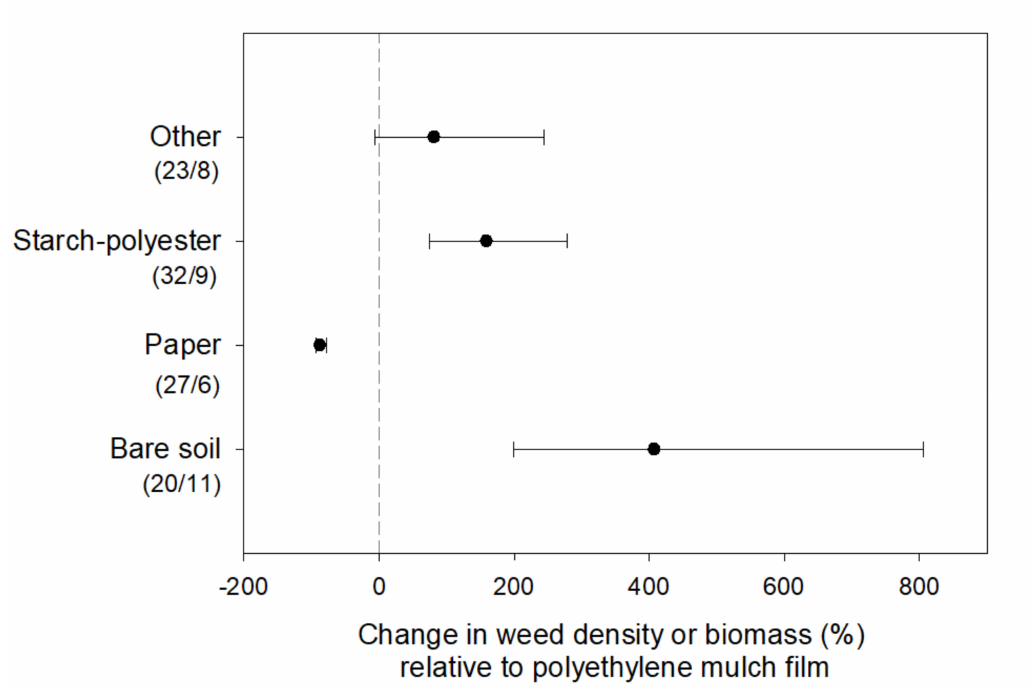
Figure 4. Mean change in weed density or biomass as influenced by bare soil and biodegradable mulch type (relative to polyethylene mulch film). Numbers below y-axis labels indicate the number of observations and studies (left / right, respectively) contributing to each mean. Error bars represent 95% confidence intervals determined via